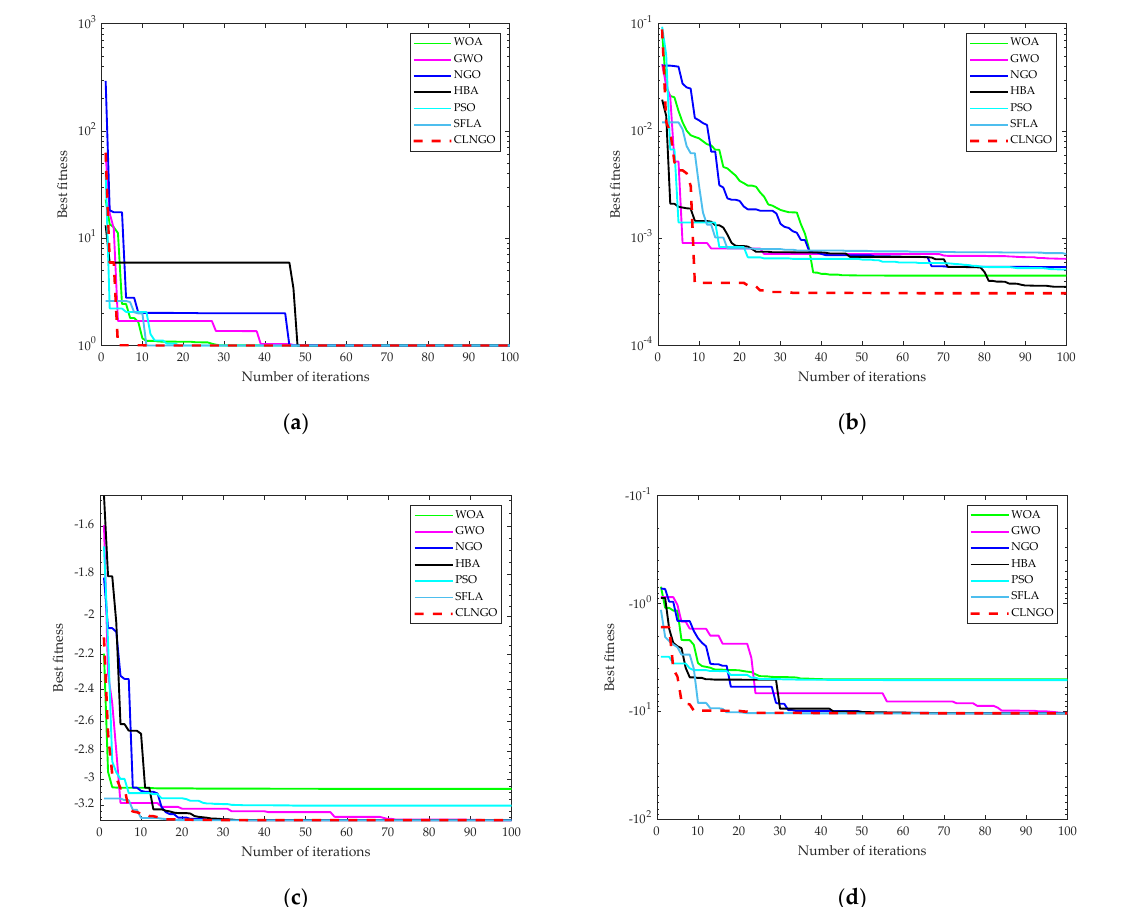
Figure 4. Convergence curve of the low-dimensional test functions. ( a ) The convergence curve of function f9. ( b ) The convergence curve of function f10. ( c ) The convergence curve of function f11. ( d ) The convergence curve of function f12